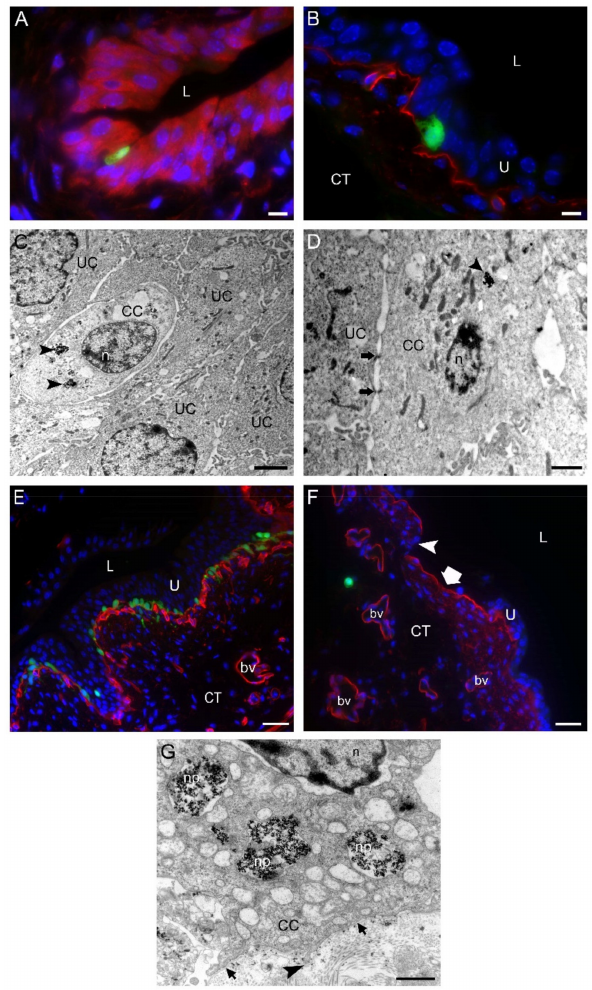
Figure 2. One to three days after intravesical application of MB49-GFP cancer cells (CC) with inter- nalized nanoparticles. ( A ) An MB49-GFP CC (green fluorescence) migrating through the urothelium toward the basal lamina. Urothelial cells were immunolabeled for keratin 7 (red fluorescence).